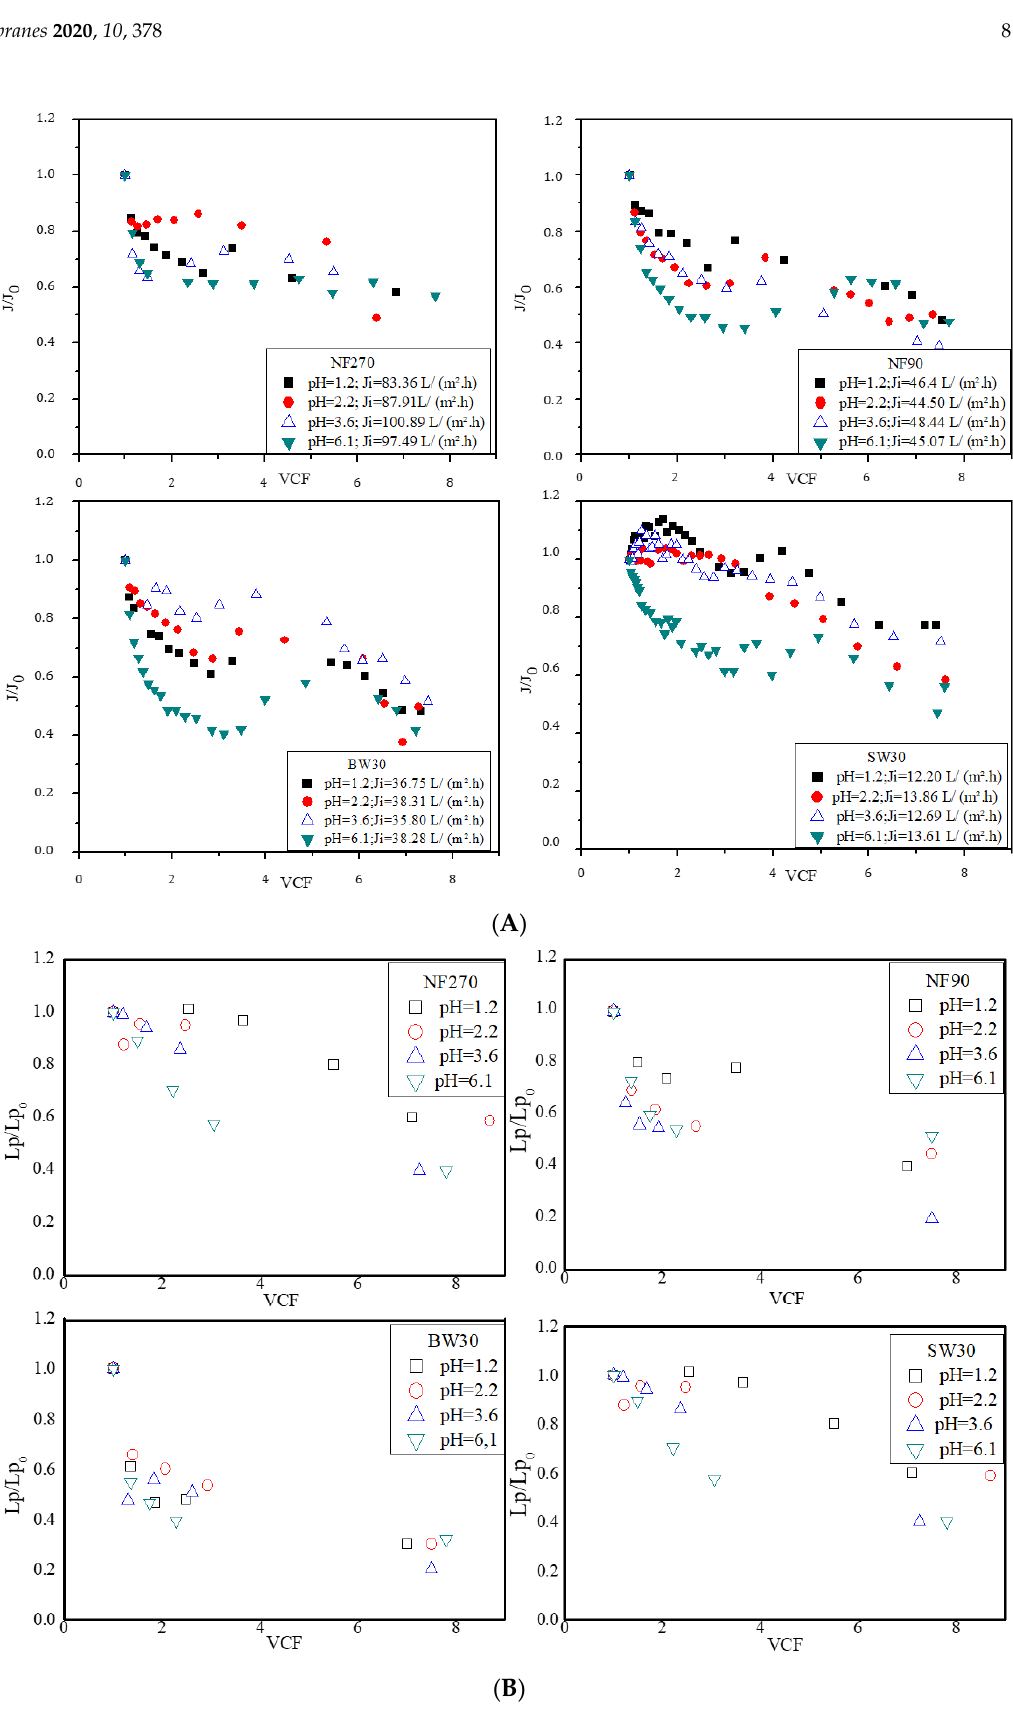
Figure 1. Evolvement of normalized permeate fluxes ( A ) and hydraulic permeabilities ( B ) versus volume concentration factors (VCFs) of a synthetic tannery effluent treated by NF and RO membranes at different pH values.